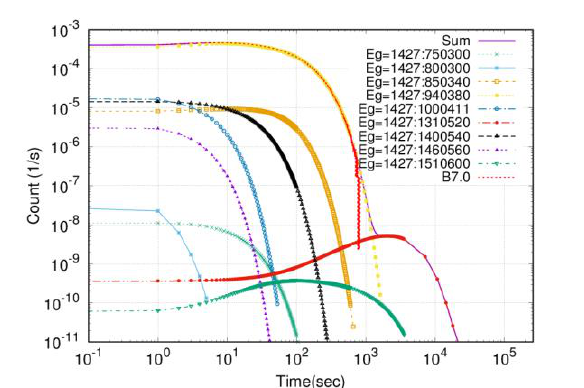
Fig. 2. Calculated BDFGs at E  =1427 keV, compared with that in ENDF/B-VII.0 for n th + 235 U fission. The legend such as ‘1427:750300 ’ denotes the γ (1427KeV) emitted from the decay of nuclide A*1000+Z*100+Isomer (A=75, Z=30, Isomer=0)